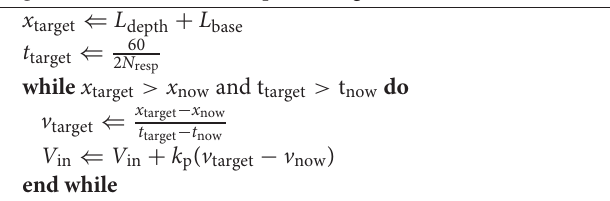
Algorithm 1 : Control of Input Voltage V in .